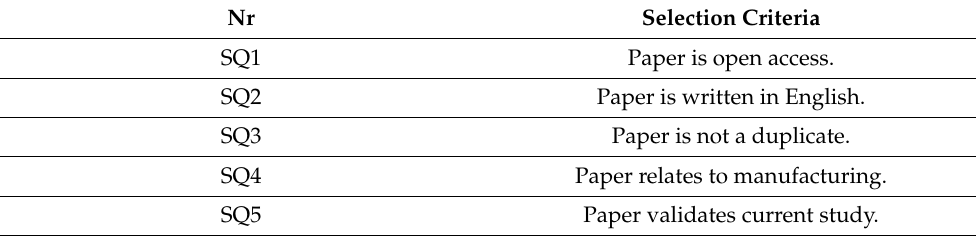
Table 1. Selection criteria applied to